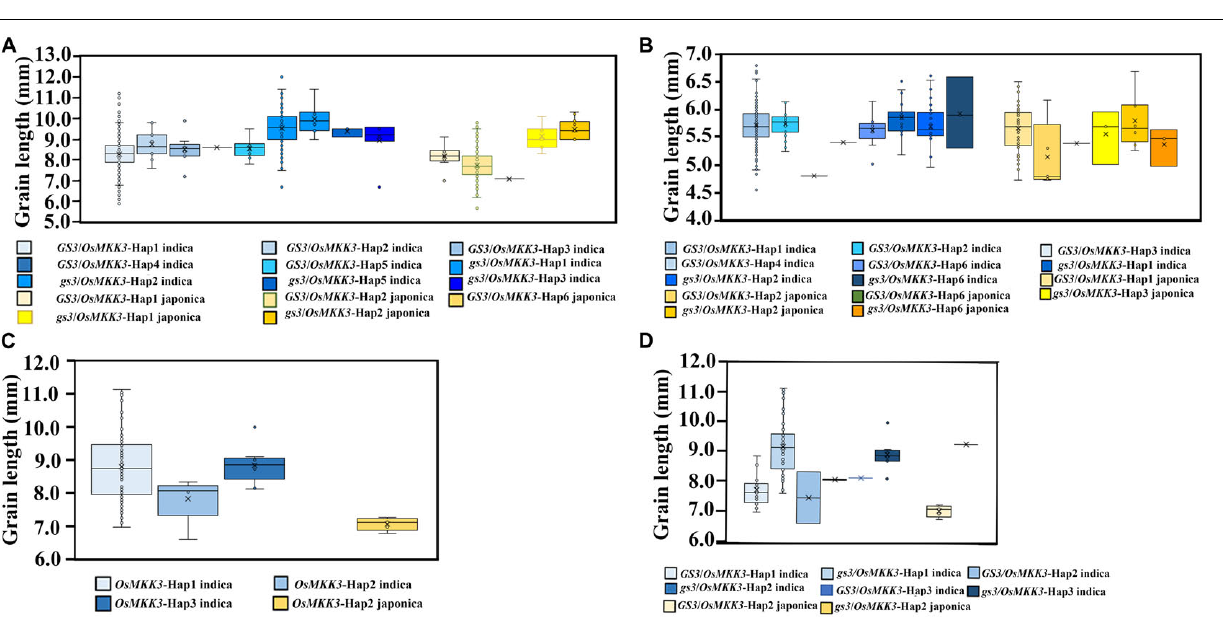
OsMKK3 -Hap1/ gs3 / GW8 and OsMKK3 -Hap1/ GS3 / gw8 . Grain length increased with OsMKK3 -Hap1/ gs3 / gw8 ( Figure 6B